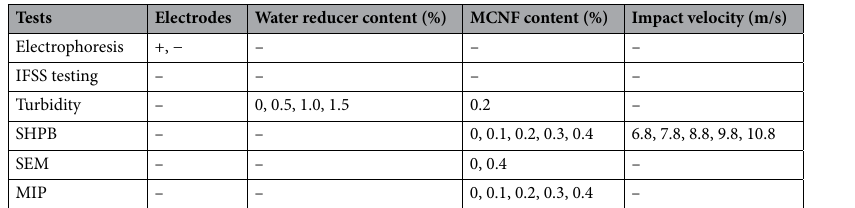
Table 4. The specific tests